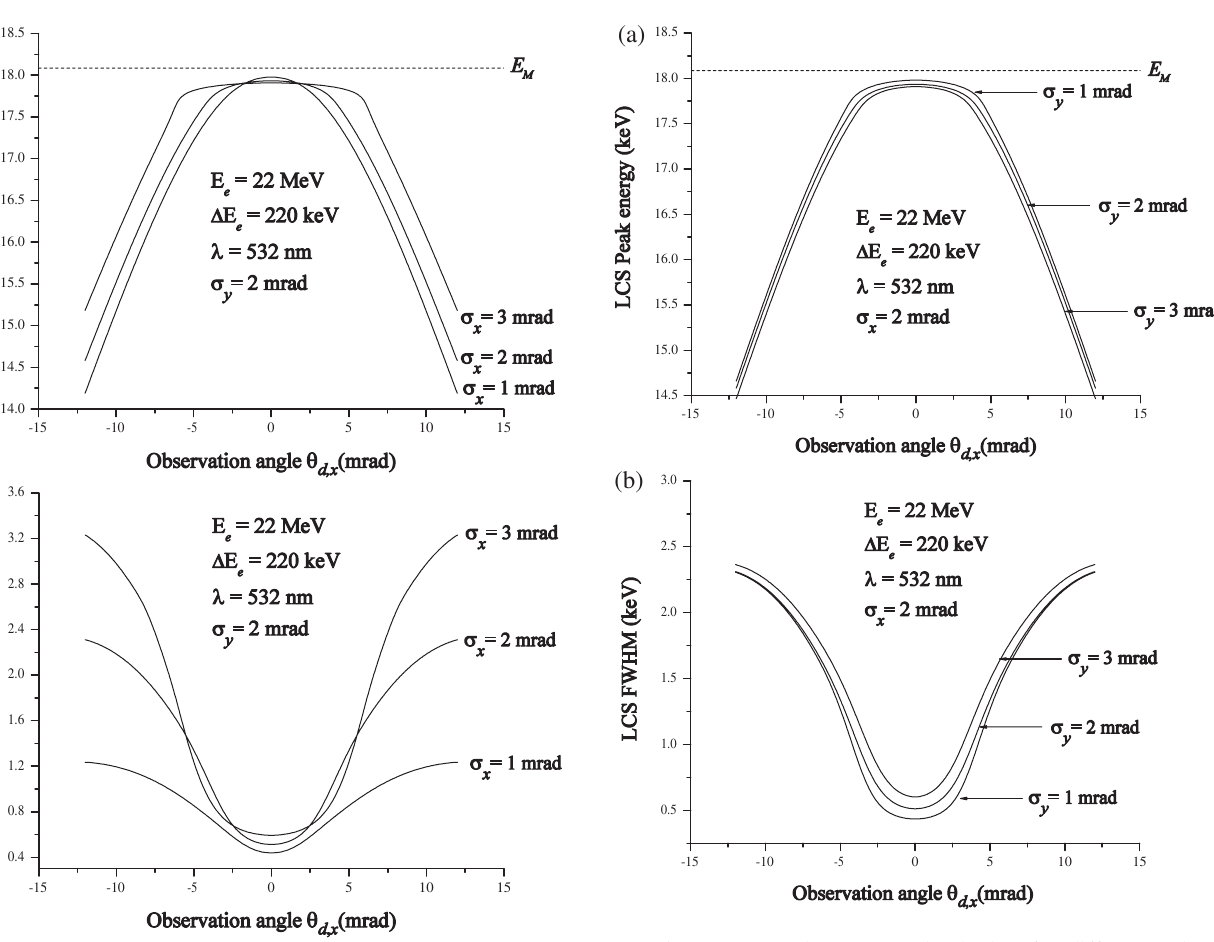
FIG. 4. (a) Variation of LCS peak energy and (b) FWHM as a function of detector angle (cid:3) direction for different values of (cid:6) the laser electric field direction (vertical direction, i.e., (cid:3) 0 mrad ). In (a) the angles at which the energy curves intersect are roughly equal to (cid:3) (cid:6) different vertical rms widths of the electron beam angular distribution. The dotted line corresponds to the value of the maximum x-ray energy E generated using Eq. (3).